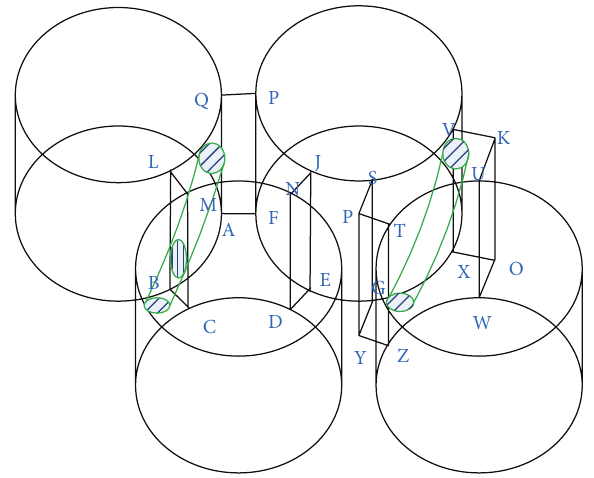
Figure 1: Three-dimensional view of a subchannel and a gap with wire